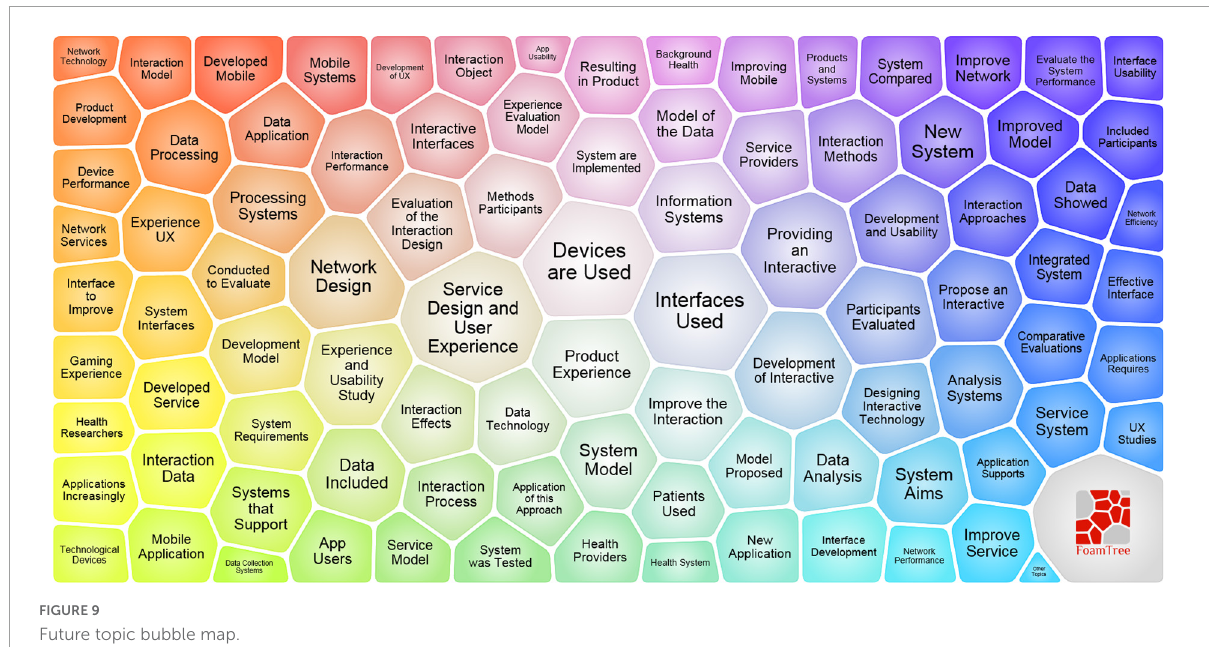
FIGURE9 Future topic bubble